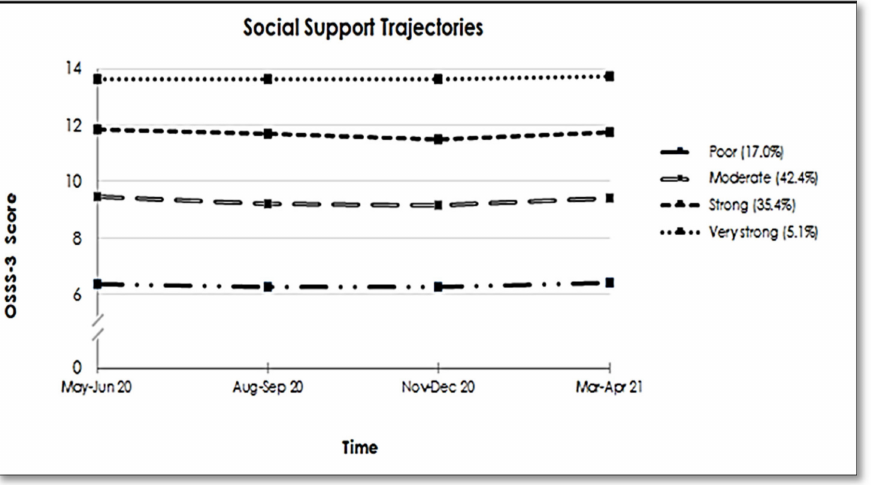
Figure 1. Trajectories of Social Support among the French participants of the COMET study (N =